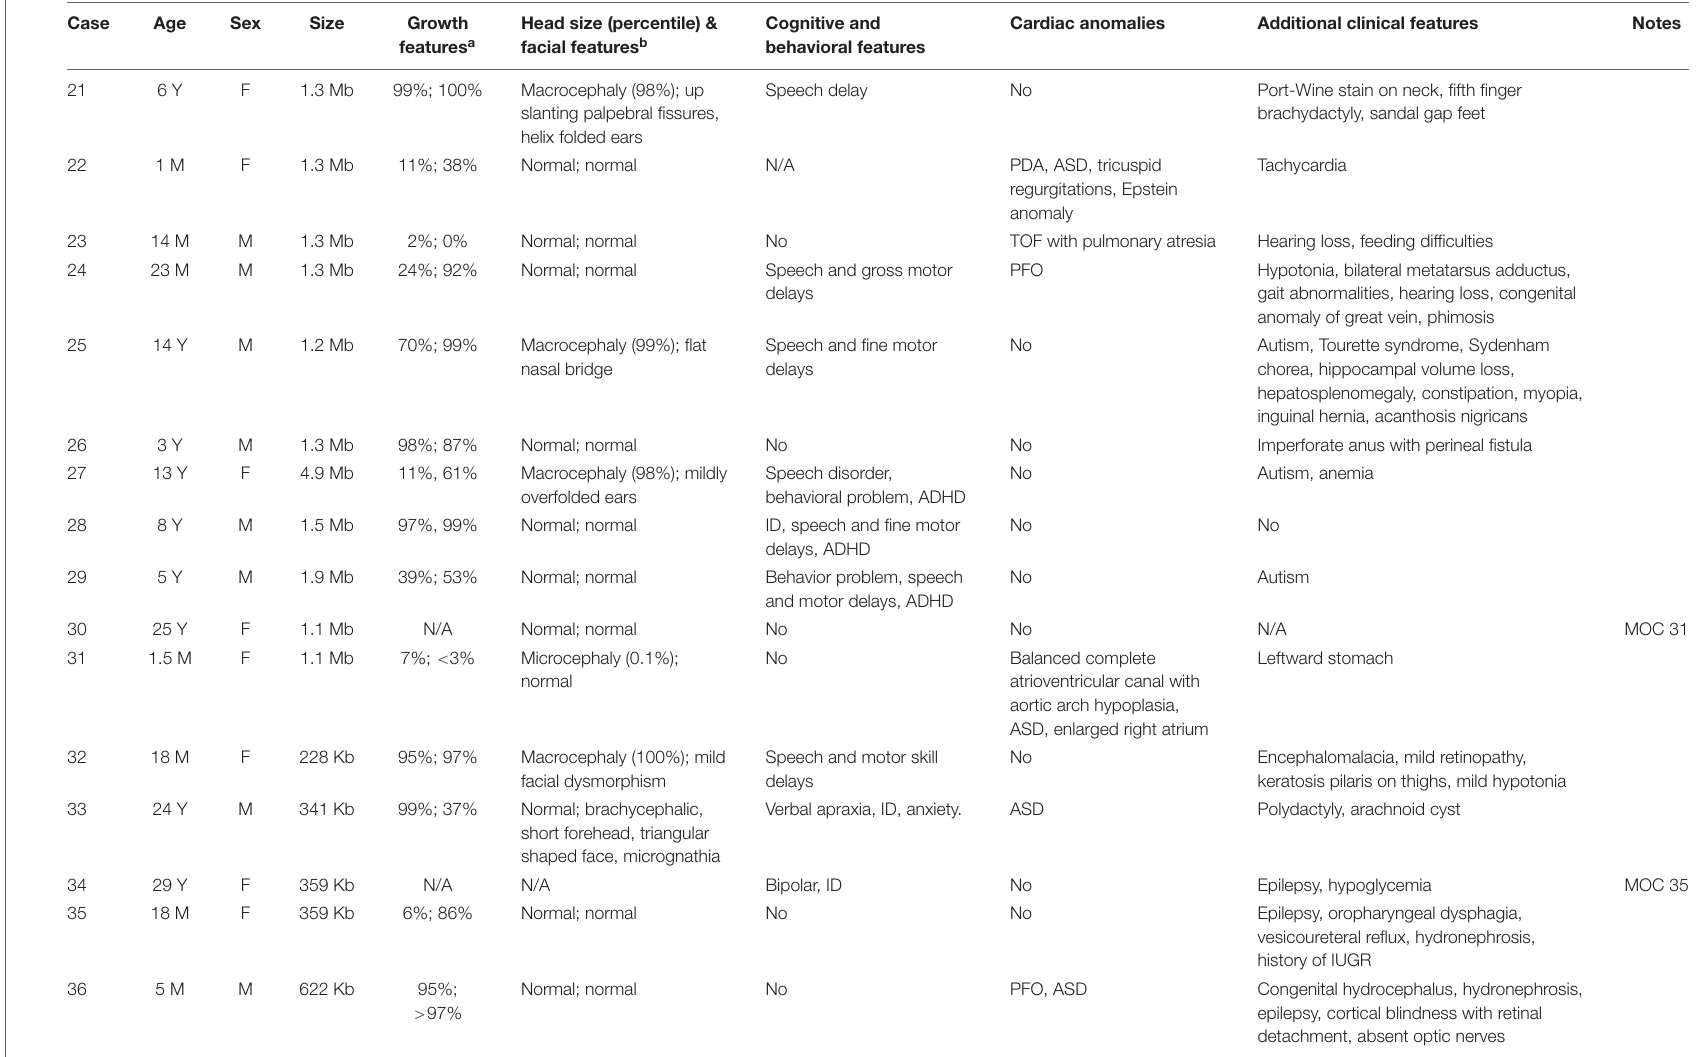
TABLE 2 | Molecular characterization and phenotypical features for individuals with 1q21.1 duplications.